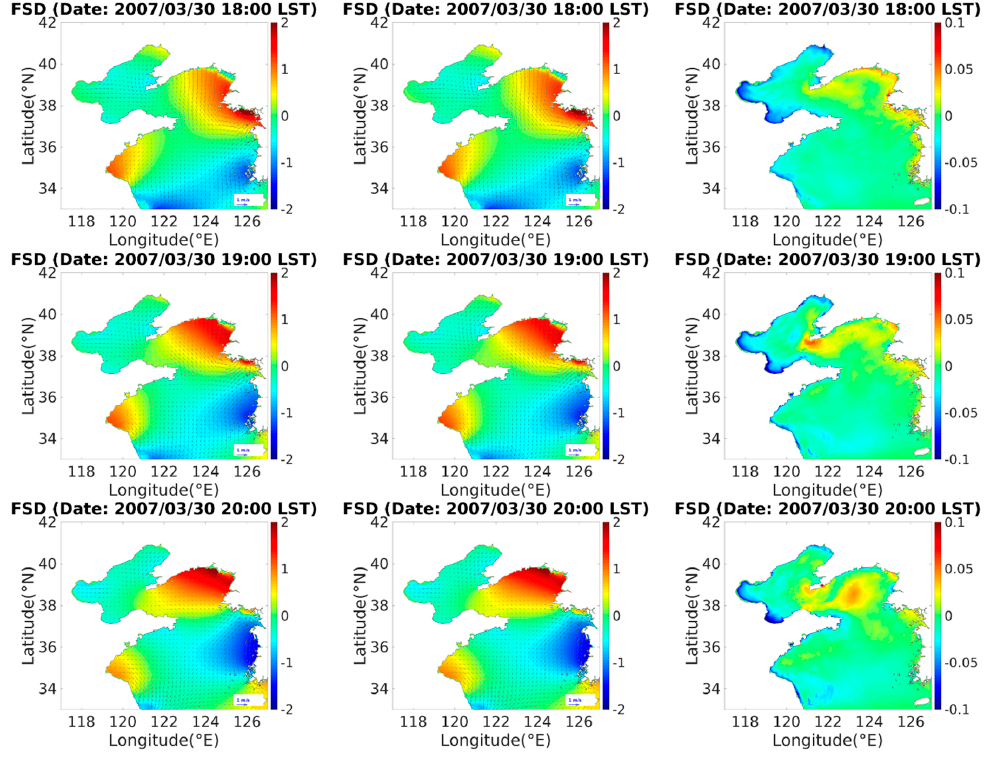
Figure 7. The free surface displacement (FSD, bottom) and sea level pressure (SLP, above) change in the Yellow Sea during the meteotsunami that occurred in March 2007. ( a ) 1800 LST 30 Mar 2007; ( b ) 1900 LST 30 Mar 2007; ( c ) 2000 LST 30 Mar 2007; ( d ) 2100 LST 30 Mar 2007; ( e ) 2200 LST 30 Mar 2007; ( f ) 2300 LST 30 Mar 2007; ( g ) 0000 LST 31 Mar 2007; ( h )